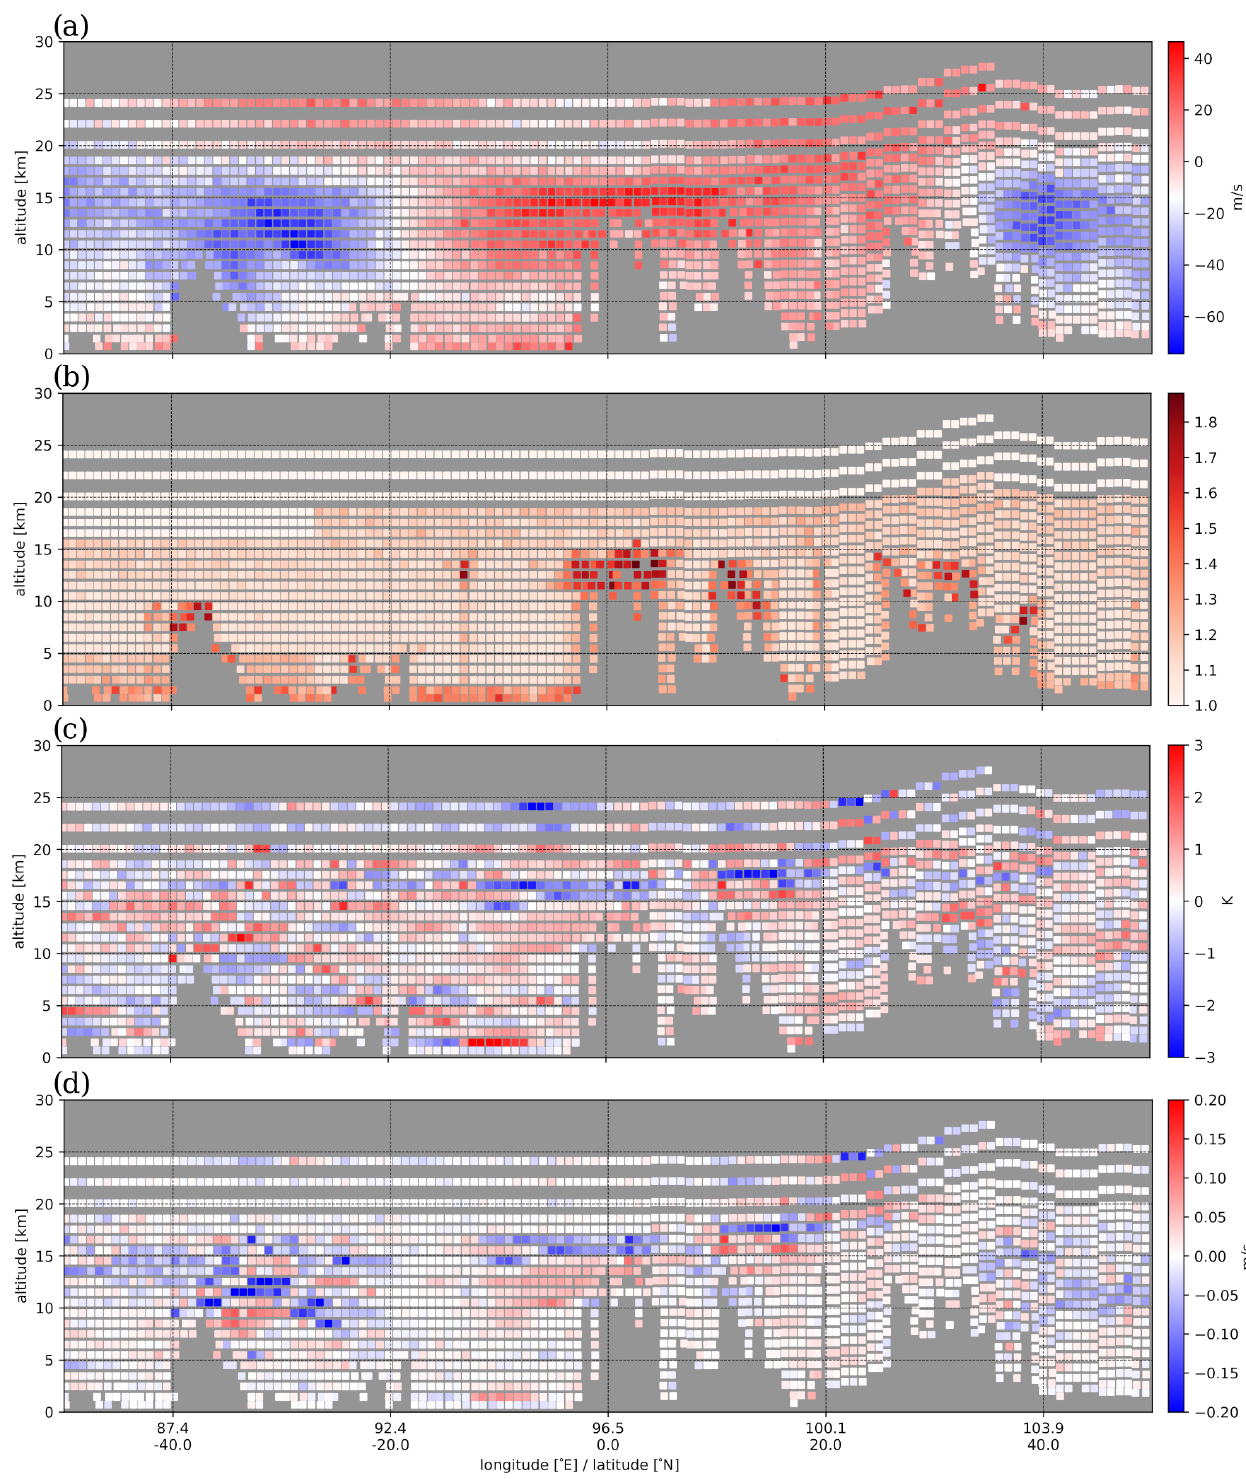
Figure 6. Vertical cross-section of an Aeolus orbit extending over the area of South Indian Ocean, tropical Indian Ocean and Southeast Asia on 13 September 2019 at about 23:00UTC. (a) A HLOS ecmwf wind amplitude, (b) scattering ratio, (c) (cid:49)T , i.e. a temperature difference between ARPEGE and IFS and the resulting (d) (cid:49) HLOS as specified by Eq. (3). Note: dimensions of coloured boxes are symbolic, hence, not representing the area of representativeness of